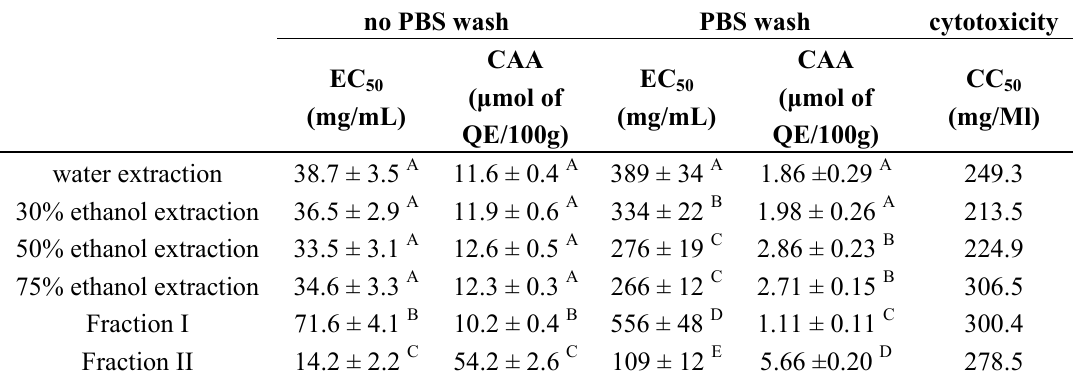
Table 4. Cellular antioxidant activity of chestnut burs extracts and